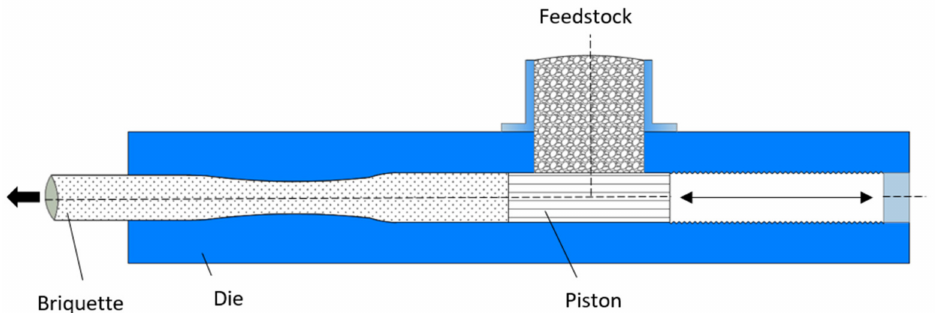
Figure 1. Hydraulic or mechanical piston press. Reprint with permission [17]; Copyright 2021, John Wiley and